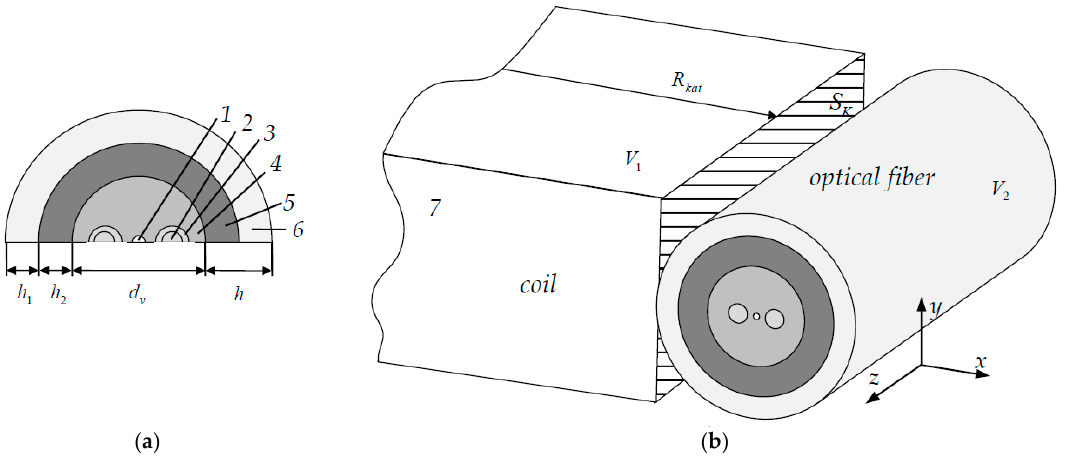
Figure 1. Design scheme: ( a ) the fiber cross-section; ( b ) the three-dimensional model; 1, the light- conducting core; 2, the inner layer of the power element; 3, the outer layer of the power element; 4, the quartz glass; 5, the primary PC; 6, the secondary PC; 7, the aluminum coil. A fiber with tension force of 0.2 N was wound in one row on an aluminum coil and sub- jected to thermal cycling according to the given law within the framework of the ure 1.